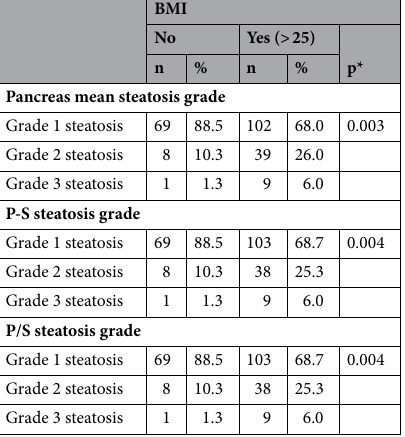
Liver steatosis on CT